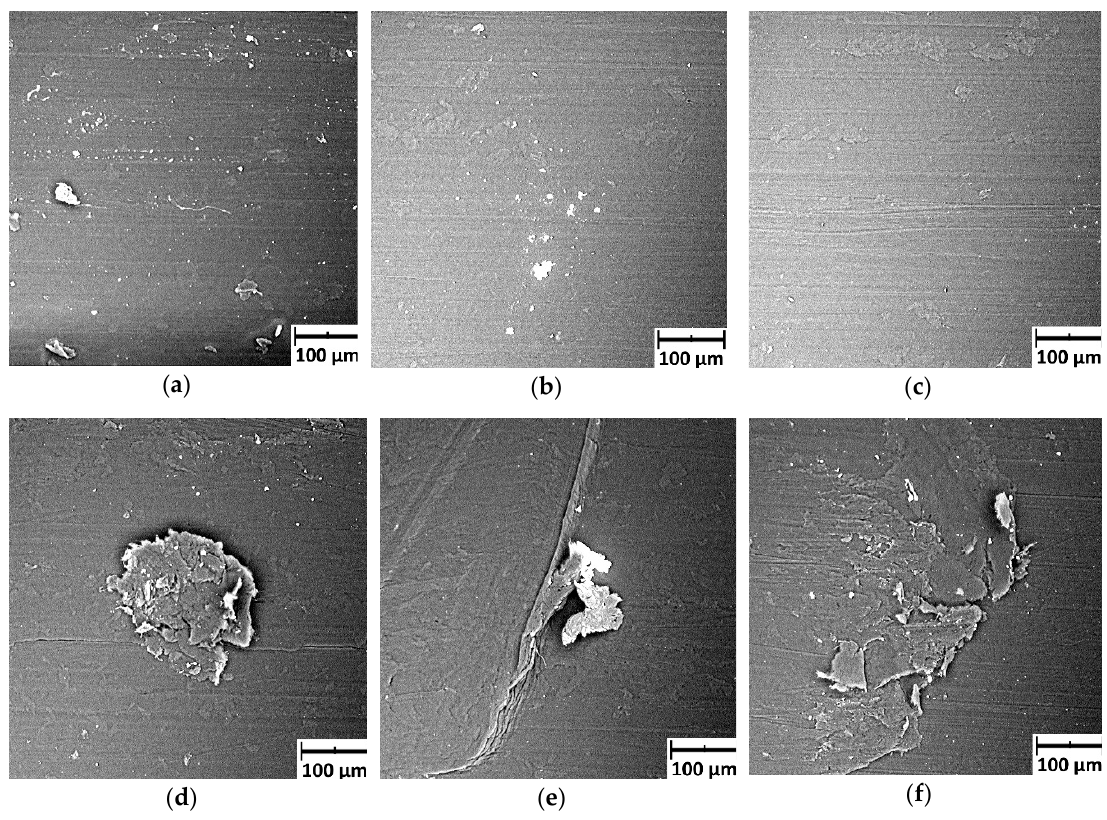
Figure 15. Selected SEM microscopic images of PE-HD surface after frictional interaction with a steel roll: ( a–c ) undeformed polymer and ( d–f ) polymer deformed to ε = 20%.